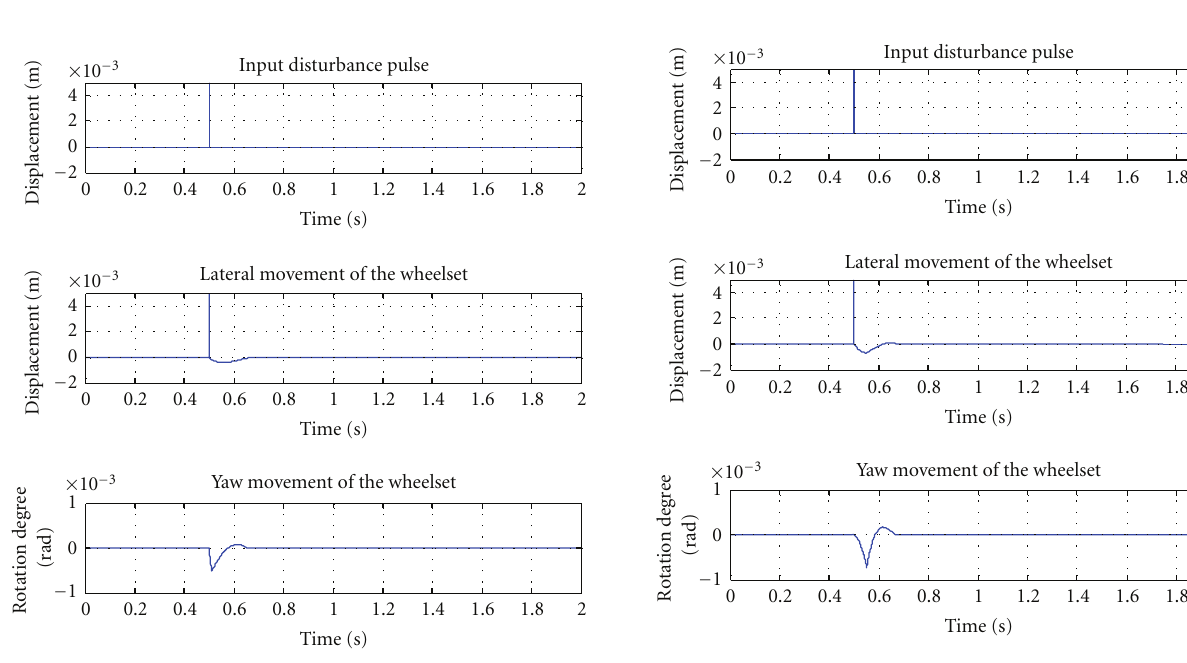
Figure 6: A wheelset with active motor control at 30 m/s running speed.